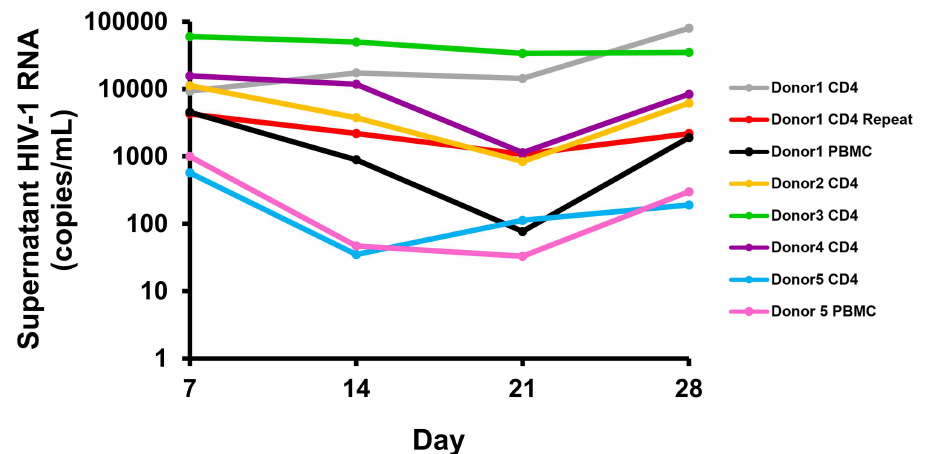
Fig 5. Levels of HIV virion production during cell culture. HIV virion production was measuredon cell- free supernatants using the Roche COBAS AmpliPrep/TaqMan HIV-1 test. The cumulativelevels of virus produced spontaneously after 24 hours in separate experiments were < 20